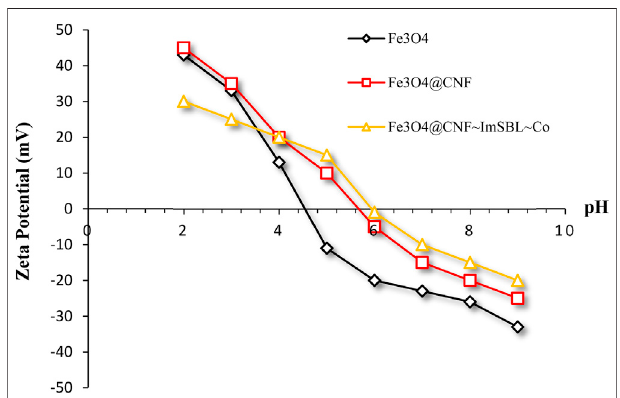
FIGURE 10 | Zeta potential values of bare magnetite and coated particles at variable